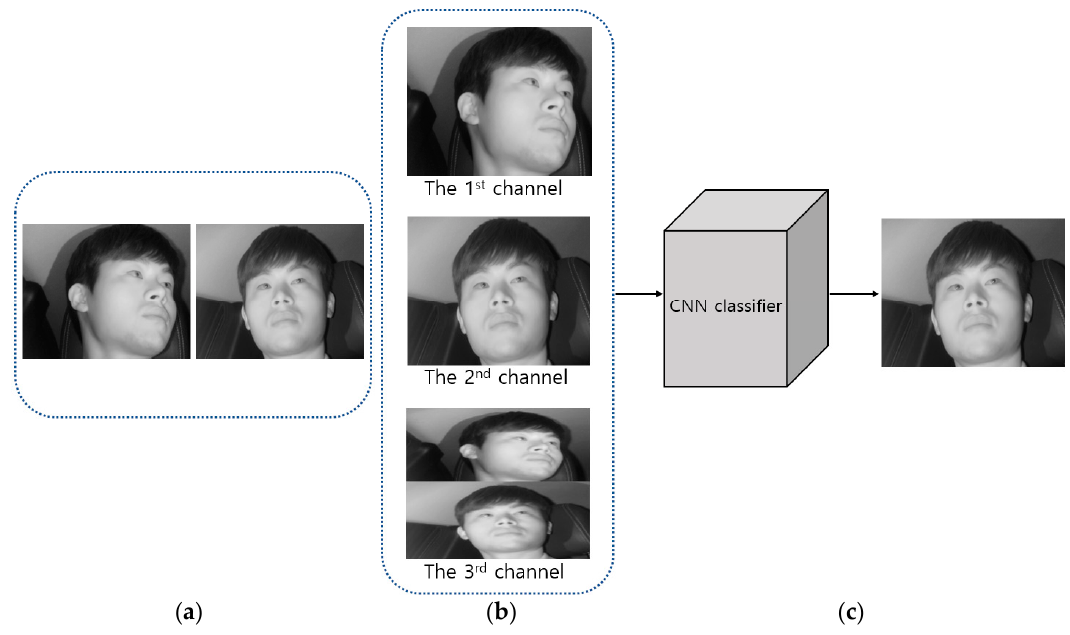
Figure 3. Classification of frontal face image. ( a ) Image captured through the 1st camera and the 2nd camera; ( b ) Combined three-channel image for the input to shallow CNN; ( c ) Selected frontal face image.